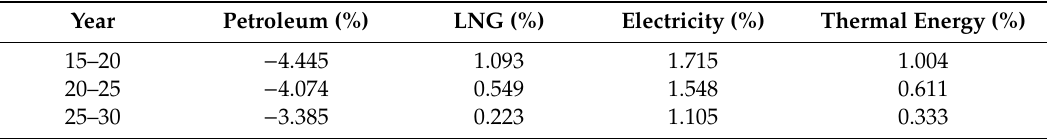
Table 2. The rate of increase in fuel consumption (Building sector, Sejong City prediction criteria) a